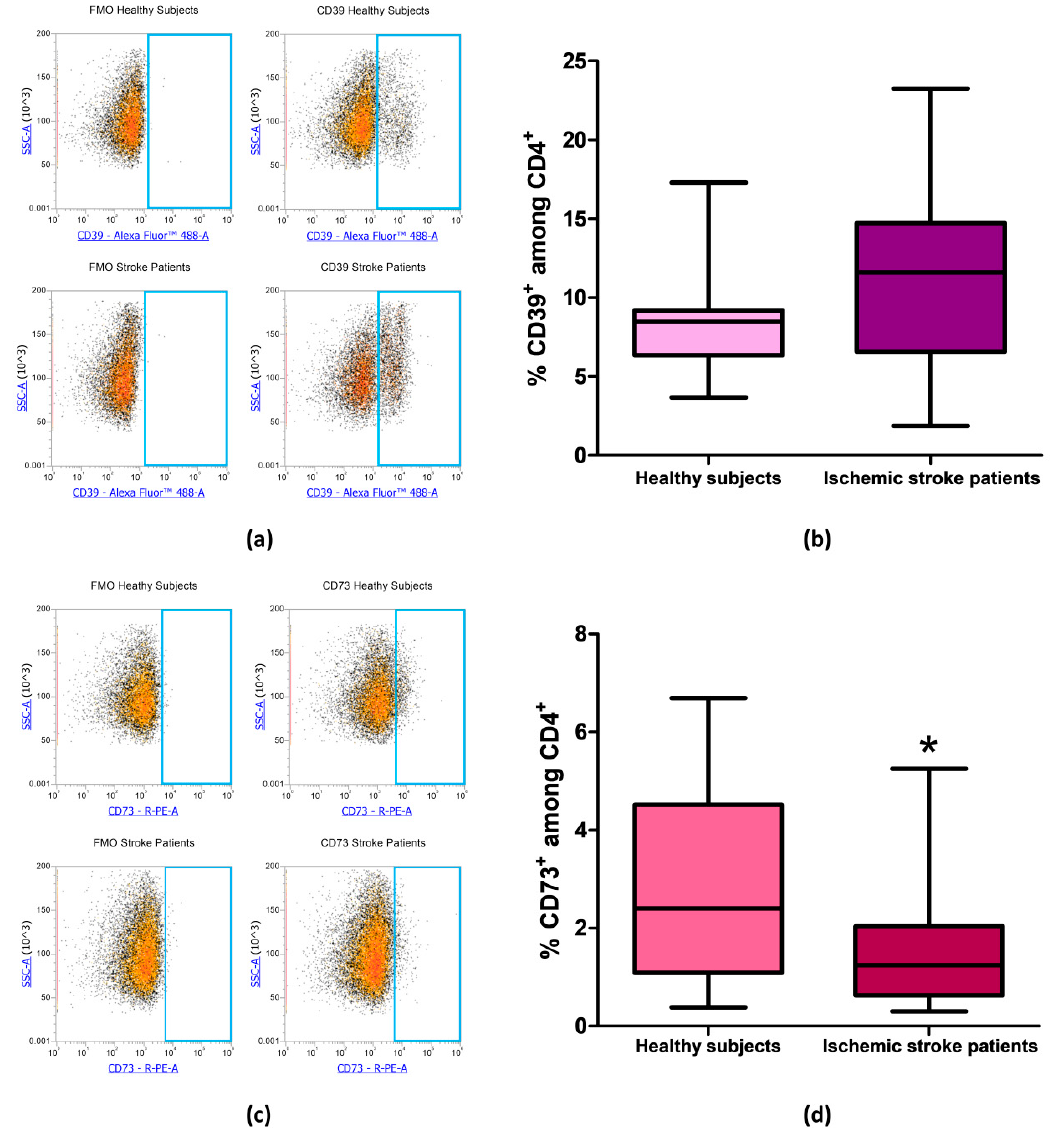
Figure 4. ( a ) Representative flow cytometry density plots showing FMO control and CD39 stained cells in CD4 + lymphocytes from healthy subjects and ischemic stroke patients. ( b ) Graphical representation of flow cytometry data showing the CD39 + percentage of CD4 + lymphocytes in healthy subjects (n = 20) and ischemic stroke patients (n = 21) . ( c ) Exemplary density plots showing FMO control and CD73 stained cells in CD4 + lymphocytes from healthy subjects and ischemic stroke patients. ( d ) Box and Whiskers plot showing the proportion of CD73 + cells among CD4 + lymphocytes in healthy subjects (n = 20) and ischemic stroke patients (n = 21) . Data are shown as the median, interquartile range and the minimum and maximum values. * p < 0.05 vs healthy subjects.